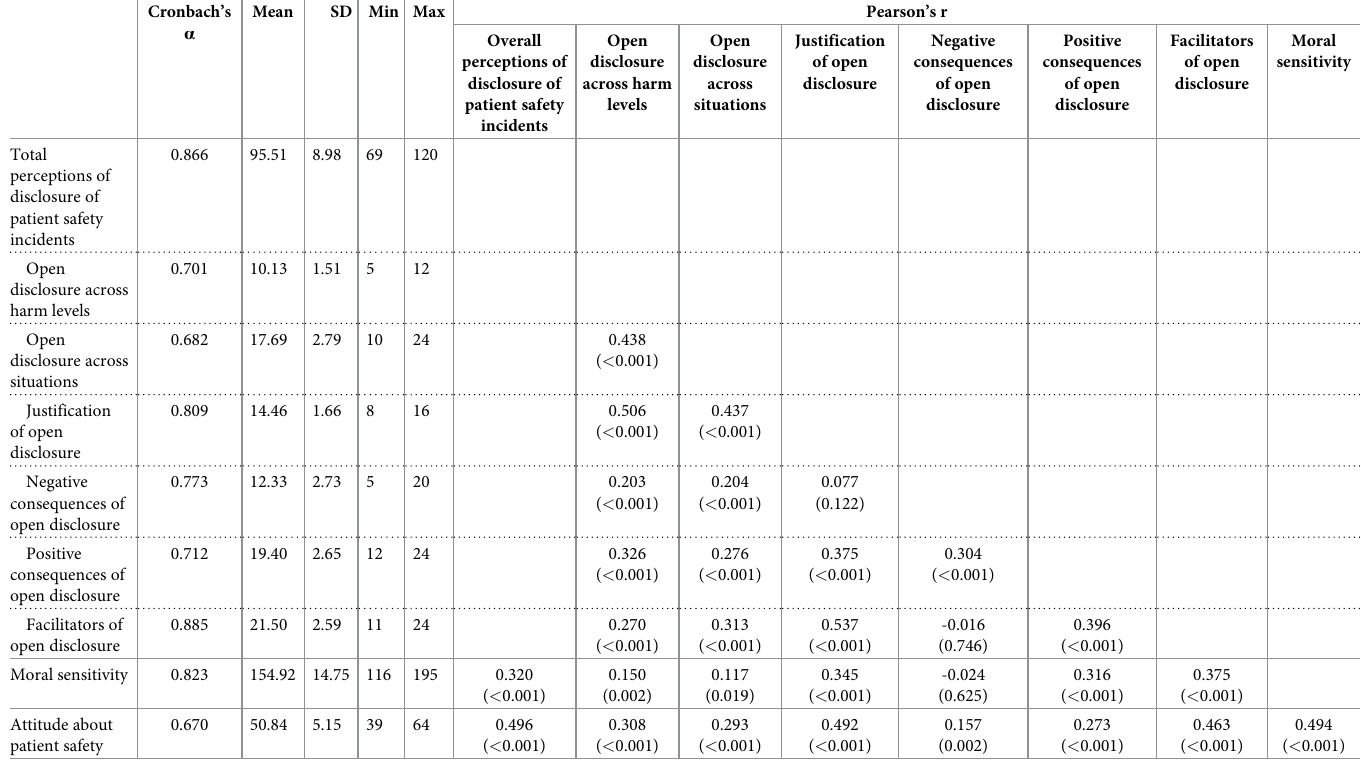
Table 4. Correlations between perceptions of disclosure of patient safety incidents, moral sensitivity, and attitude about patient safety.